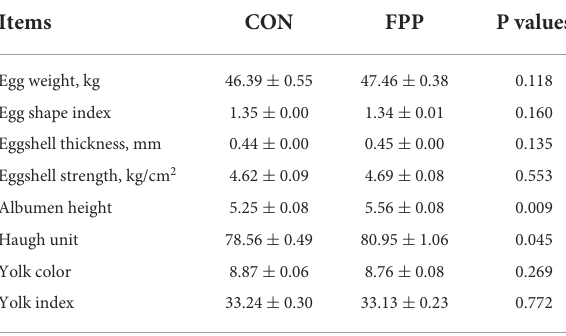
TABLE 4 Effects of FPP on the egg quality of laying